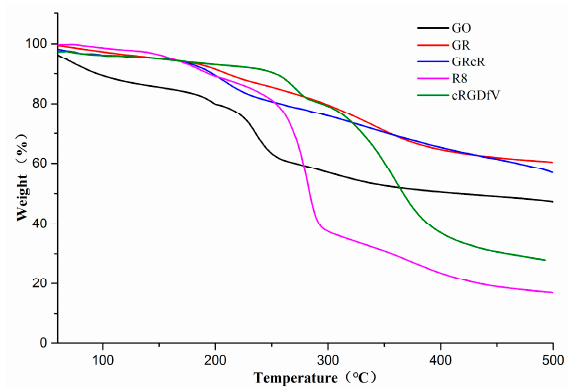
Figure 7. Thermal gravimetric analyzer (TGA) spectra of GO (black), GR (red), GRcR (blue), R8 (purple), and cRGDfV (green).